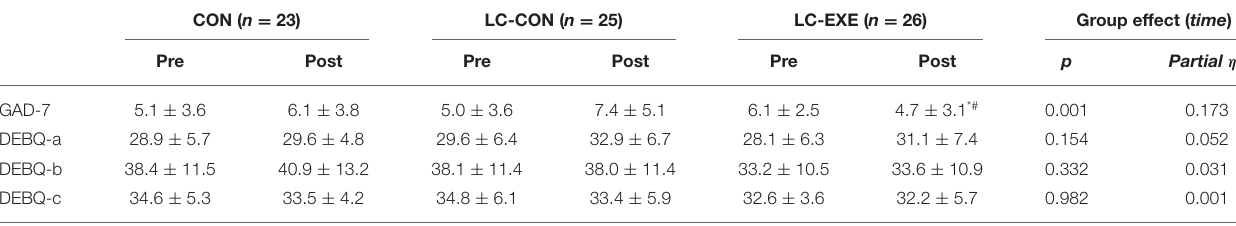
TABLE 4 | Outcome variables before and after 4 weeks of intervention. CON ( n = 23) LC-CON ( n = 25) LC-EXE ( n = 26) Group effect ( time ) Pre Post Pre Post Pre Post p Partial η 2 GAD-7